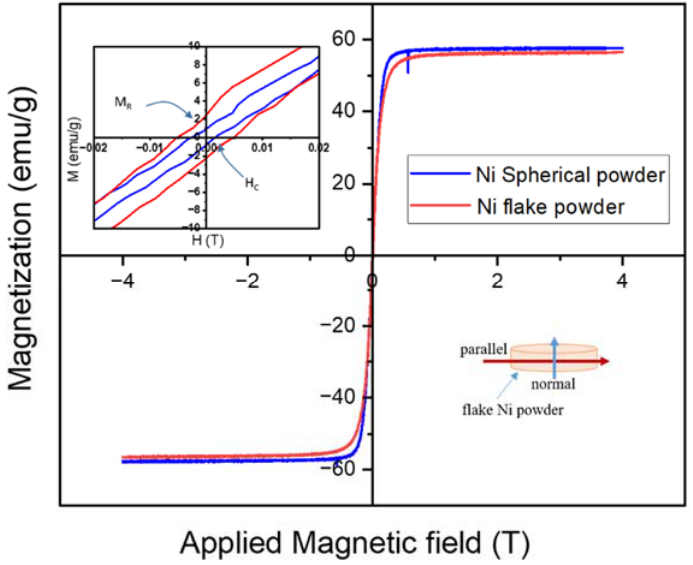
Figure 8. Magnetization (M) vs. applied magnetic field (H) curves for Ni spherical and flake powders at room temperature.